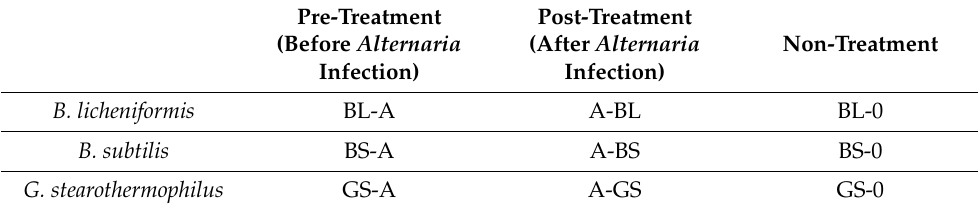
Table 1. Configurations of plant treatments.